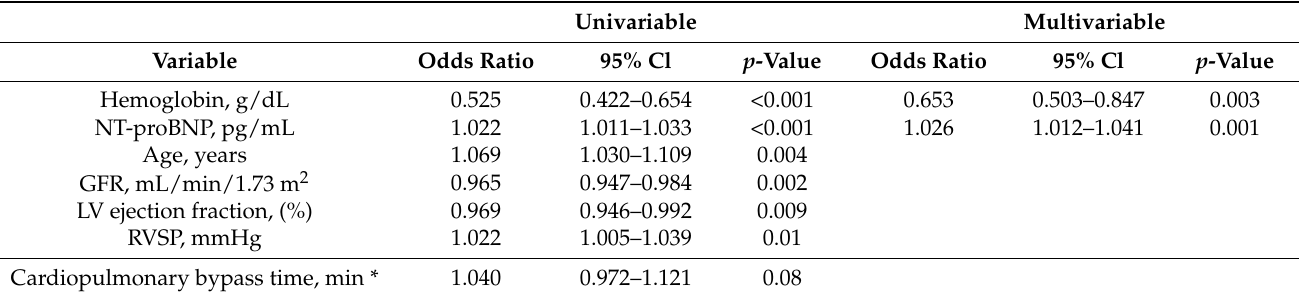
Table 2. Factors associated with postoperative multiple organ dysfunction syndrome—univariable and multivariable analyses.